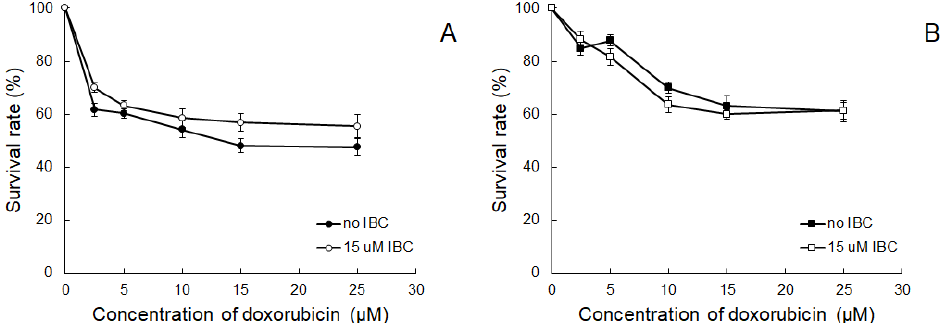
Figure 3. SRB cytotoxicity assay of Dox and Dox combined with IBC (at 15 μ M) in HT29 ( A ) and HT29/Dx cells ( B ). The means of three experiments ± SD are presented (* p < 0.05). Statistically significant differences between cells treated only with Dox and Dox combined with IBC were not detected.